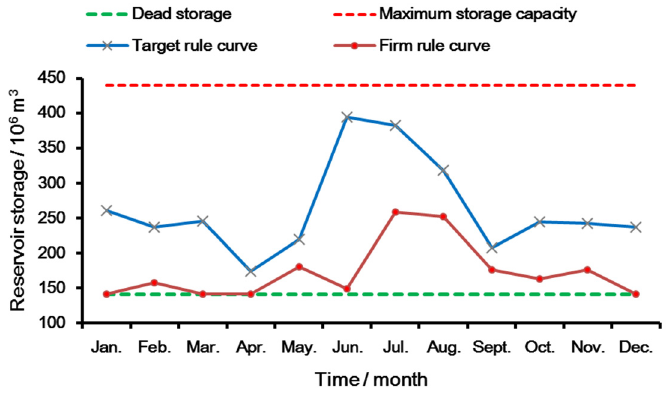
Figure 10. The rule curves obtained according to the proposed rule.